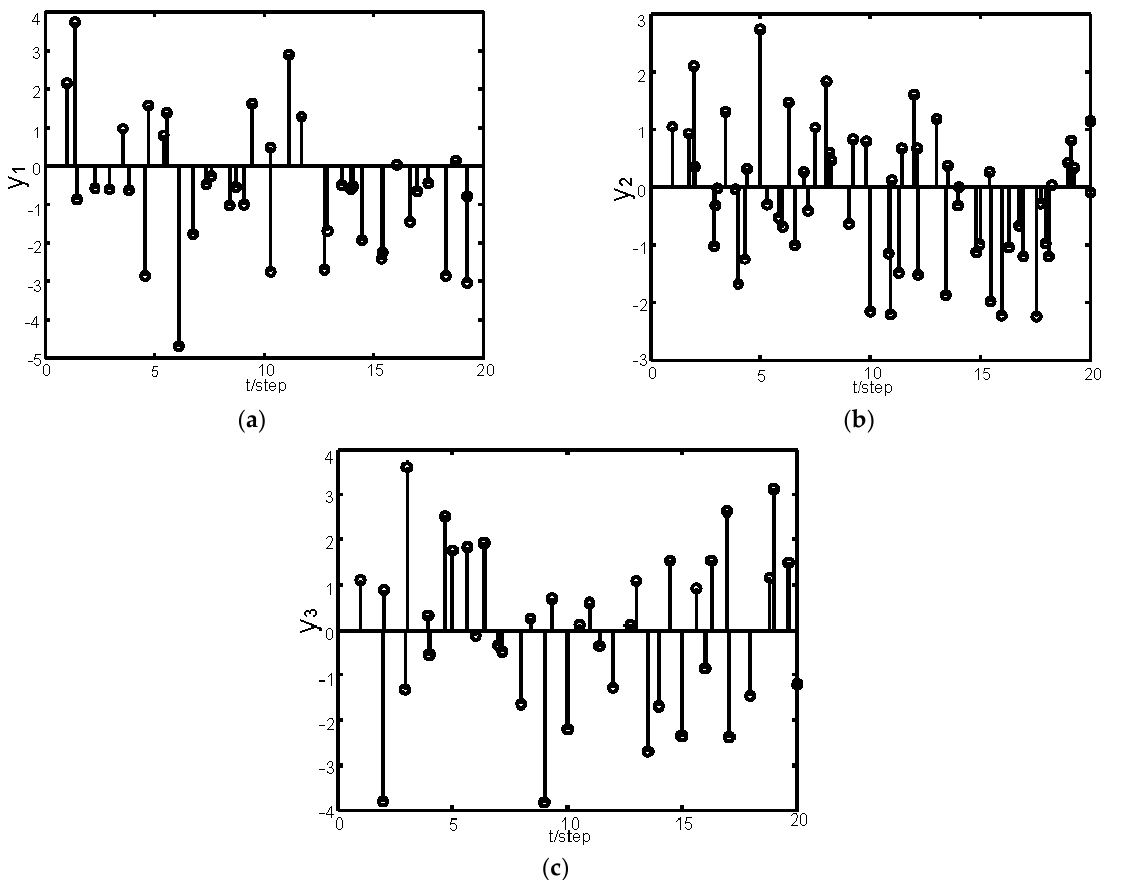
Figure 2. Samples of sensors 1–3 in [1,20]: ( a ) samples of the first sensor; ( b ) samples of the second sensor; and ( c ) samples of the third sensor.